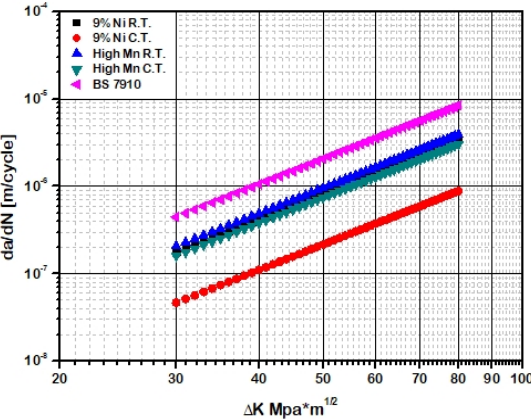
Figure 15. da / dN - Δ K curves of the weld metals compared to the BS 7910 (mean + 2 SD curve). Table 8. Comparison of material constants for the weld